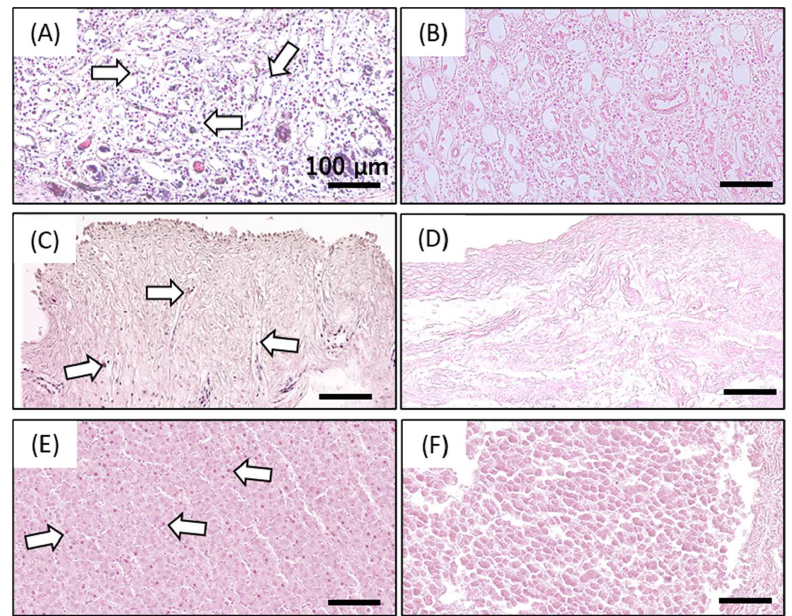
Figure 1. Photographs of hematoxylin and eosin (HE) staining of untreated small intestinal submu- cosa (SIS; A ), urinary bladder matrix (UBM; C ), liver ( E ), and decellularized SIS ( B ), UBM ( D ), and liver ( F ). The arrow represents the visible nuclear remnants. Scale bar: 100 µm.